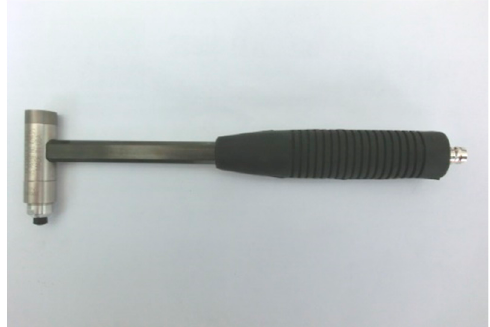
Figure 3. Modal hammer.